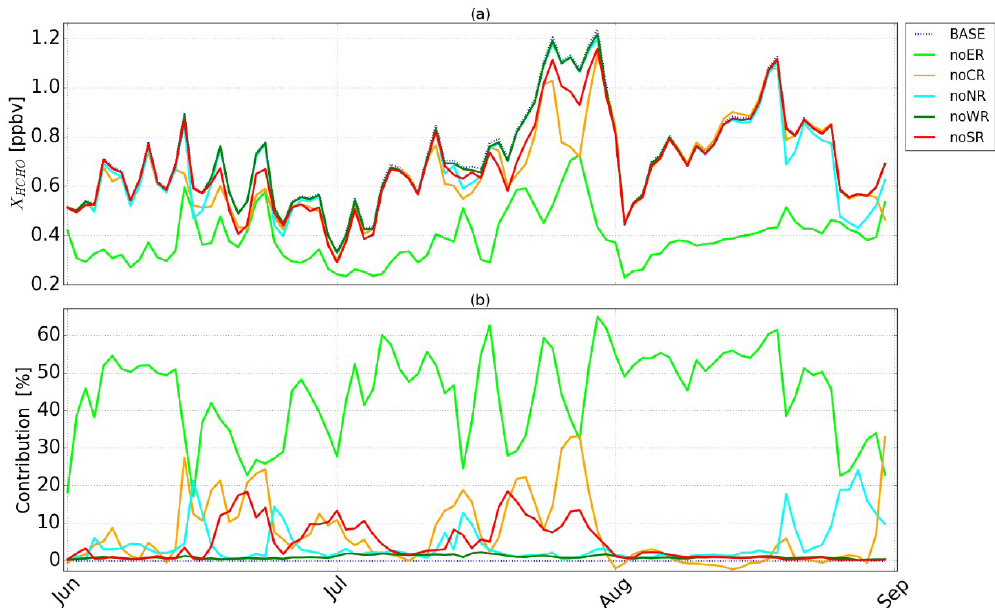
Figure 8. (a) Daily mean X HCHO (in ppbv) time series averaged over the summertime of 2015 to 2019 above Hefei simulated by GEOS- Chem, according to the BASE and sensitivity (i.e., noER, noCR, noNR, noWR, and noSR) simulations. In the sensitivity simulations, the fossil fuel, biogenic, biomass burning and biofuel emissions of all atmospheric compounds within the studied region have been shut off, while the CH 4 concentrations are still derived from NOAA measurements, as for the BASE simulation. (b) Relative contribution of each geographical region calculated as the relative difference between the BASE simulation and the corresponding sensitivity simulation (in